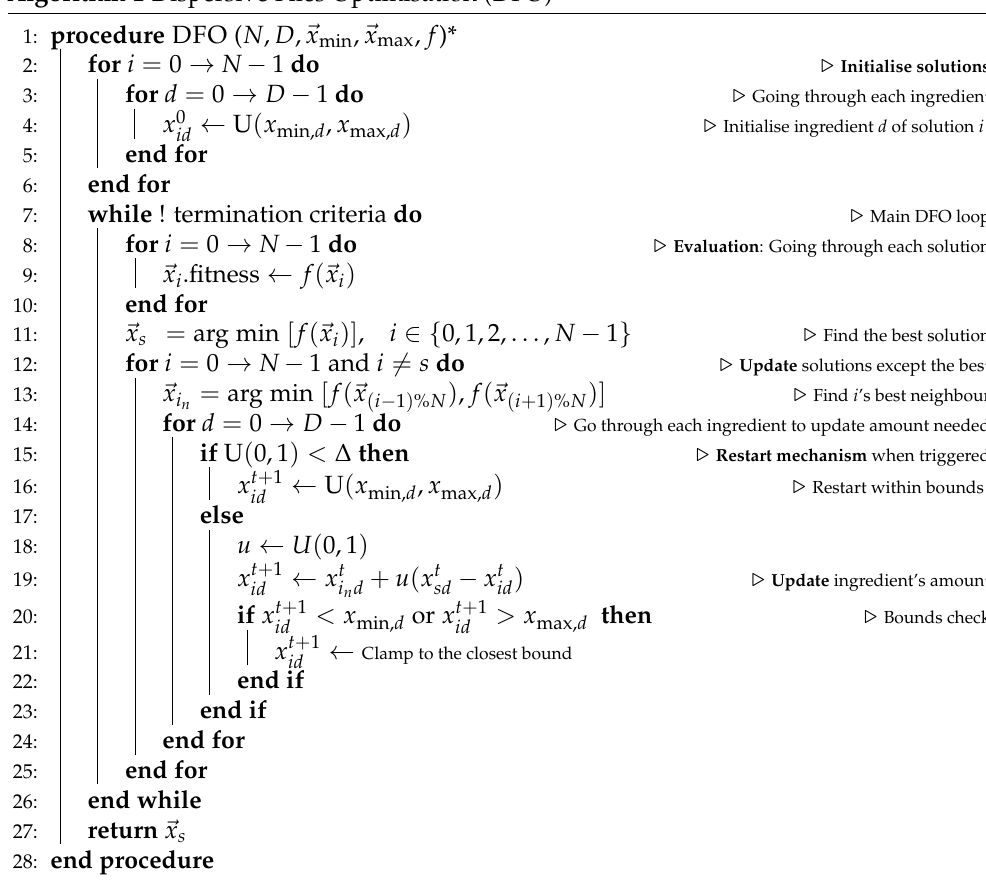
Algorithm 1 Dispersive Flies Optimisation